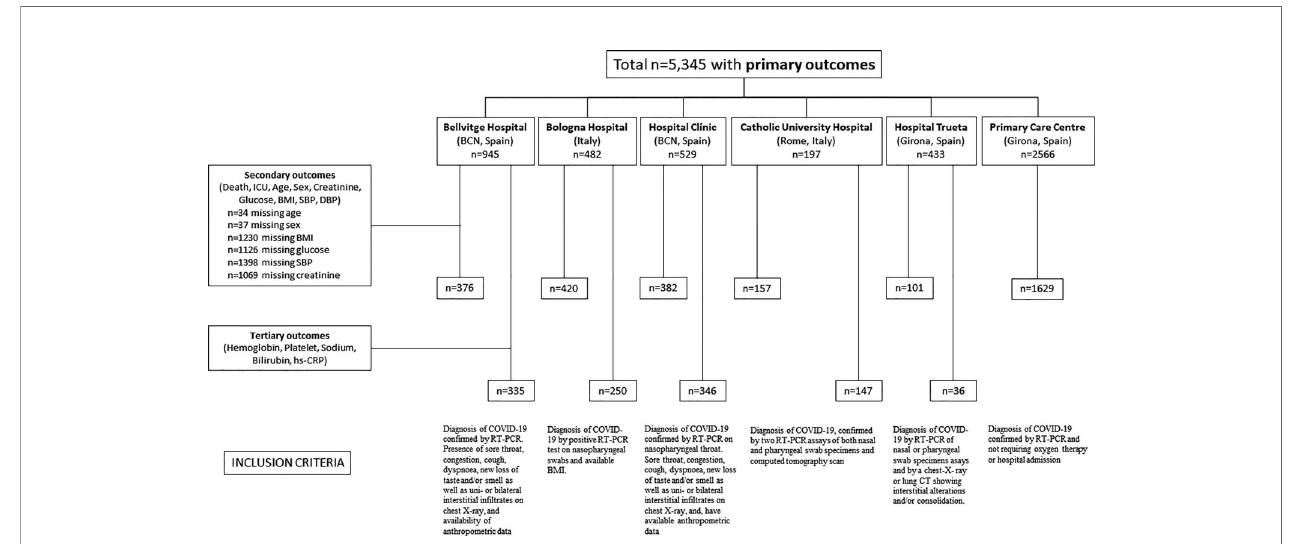
FIGURE 1 | Flow chart of study design and inclusion